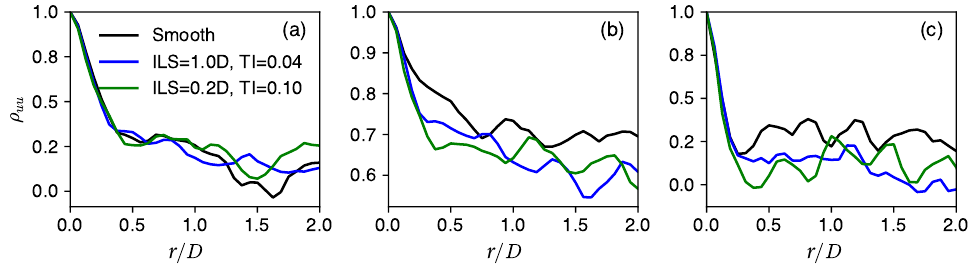
Figure 7. Spanwise correlation of streamwise velocity. The locations of a group of spanwise probes from left to right are at ( a ) wake, x / D = 1.0, y / D = 0.0, ( b ) shear layer in the wake, x / D = 1.0, y / D = 0.5, and ( c ) shear layer over the side surfaces, x / D = 0.0, y / D =